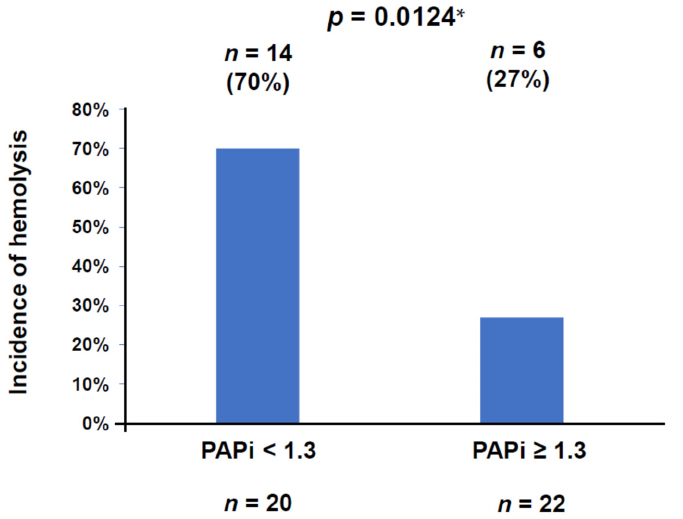
Figure 2. The incidence of hemolysis was significantly higher in the lower PAPi (<1.3) group than in the higher PAPi ( ≥ 1.3) group (70% vs. 27%, p = 0.0124) according to Fisher’s exact test. PAPi, pulmonary artery pulsatility index. * p < 0.05 by Fisher's exact test Lower PAPi (<1.3) was identified as a significant risk factor for hemolysis with an unadjusted odds ratio of 6.222 (95% confidence interval 1.630–23.758, p = 0.0049) and an odds ratio of 11.654 (95% confidence interval 1.580–85.982, p = 0.017) adjusted for serum creatinine kinase levels (>150 IU/L), which was also significant in the univariable analyses, and concomitant use of ECMO, which carries a potential risk of hemolysis [7] but did not reach statistical significance in the univariable analysis (Table 4). We did not include the occurrence of acute myocardial infarction in the multivariable analysis, considering its multicollinearity with higher creatinine kinase. Table 4. Univariable and multivariable analyses for the hemolytic event. Univariable Analyses